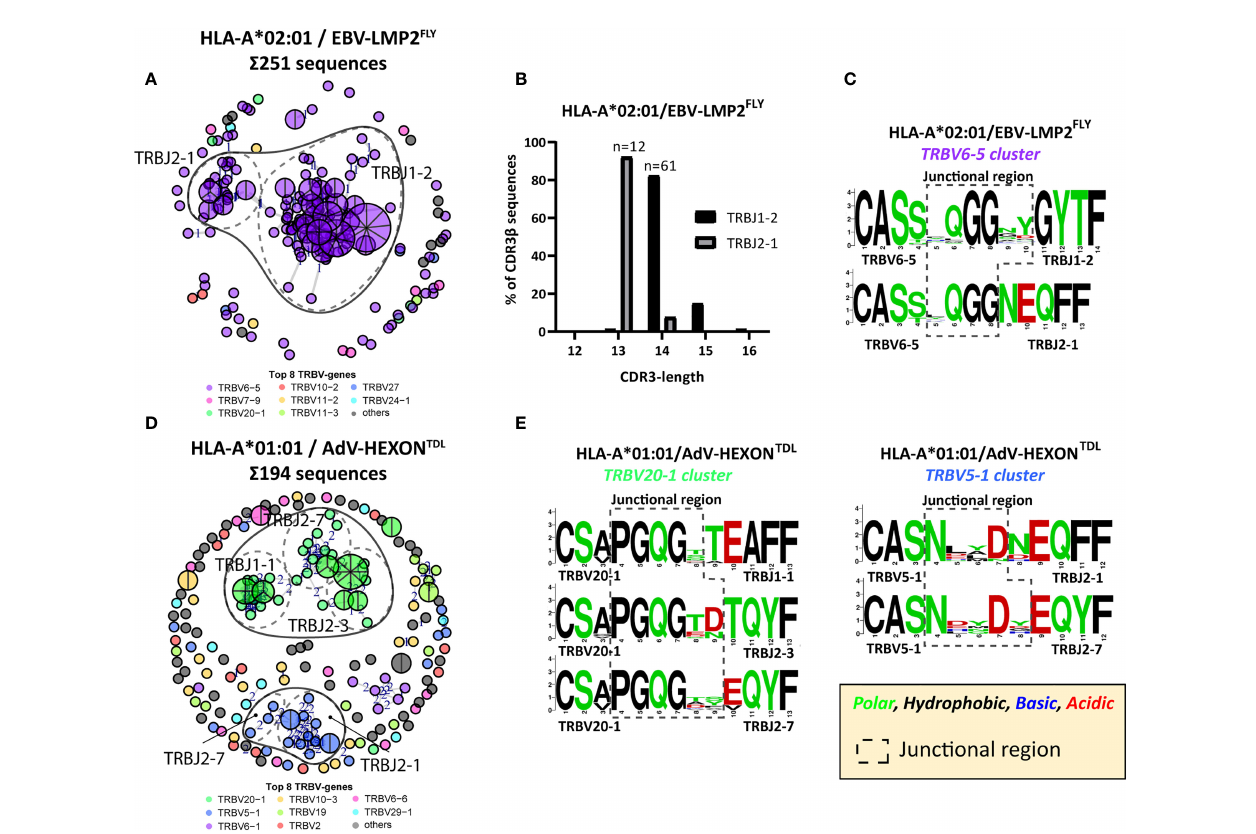
FIGURE 5 | Computation analysis reveals clustering of PUB-HS CDR3 b AA-sequences that contained conserved regions in the CDR3 b -region. Computational analysis was performed using the levenshtein distance (differences in AAs) between CDR3 b AA-sequences of one speci fi city. CDR3 b AA-sequences were plotted and colored according to the top 8 most frequent TRBV-genes and were clustered and linked by a line if they were similar, with a number (levenshtein distance of 1, 2 or 3) representing the differences in AAs. PUB-I CDR3 b AA-sequences were plotted as a pie-chart, whereby the size and number of slices indicate in how many individuals this CDR3 b AA-sequence was present. Sequence logos generated using WebLogo (http://weblogo.berkeley.edu/logo.cgi) show the relative frequency of each AA at each given position. The junctional region (AAs that do not align with the germline TRBV or TRBJ-gene) are shown within the box with the dotted-line (A) Shown is a representative example of a virus-speci fi c CD8 pos T-cell population, speci fi c for EBV-LMP2 FLY with overlapping clusters of sequences that express different TRBJ-genes, while expressing the same TRBV-gene. (B) The lengths of the CDR3 b -regions of the two clusters of EBV-LMP2 FLY -speci fi c CDR3 b -sequences are shown. Varying lengths of the CDR3 b -region within a cluster would suggest deletions or insertions, whereby the same length would indicate AA substitutions. (C) Shown are the sequence motifs of the two EBV-LMP2 FLY -speci fi c clusters. (D) Shown is a second representative example of a virus-speci fi c CD8 pos T-cell population, speci fi c for AdV-HEXON TDL , with overlapping clusters of sequences that express different TRBJ-genes, while expressing the same TRBV-gene. (E) Shown are the sequence motifs of the TRBV20-1 and TRBV5-1-expressing EBV-HEXON TDL -speci fi